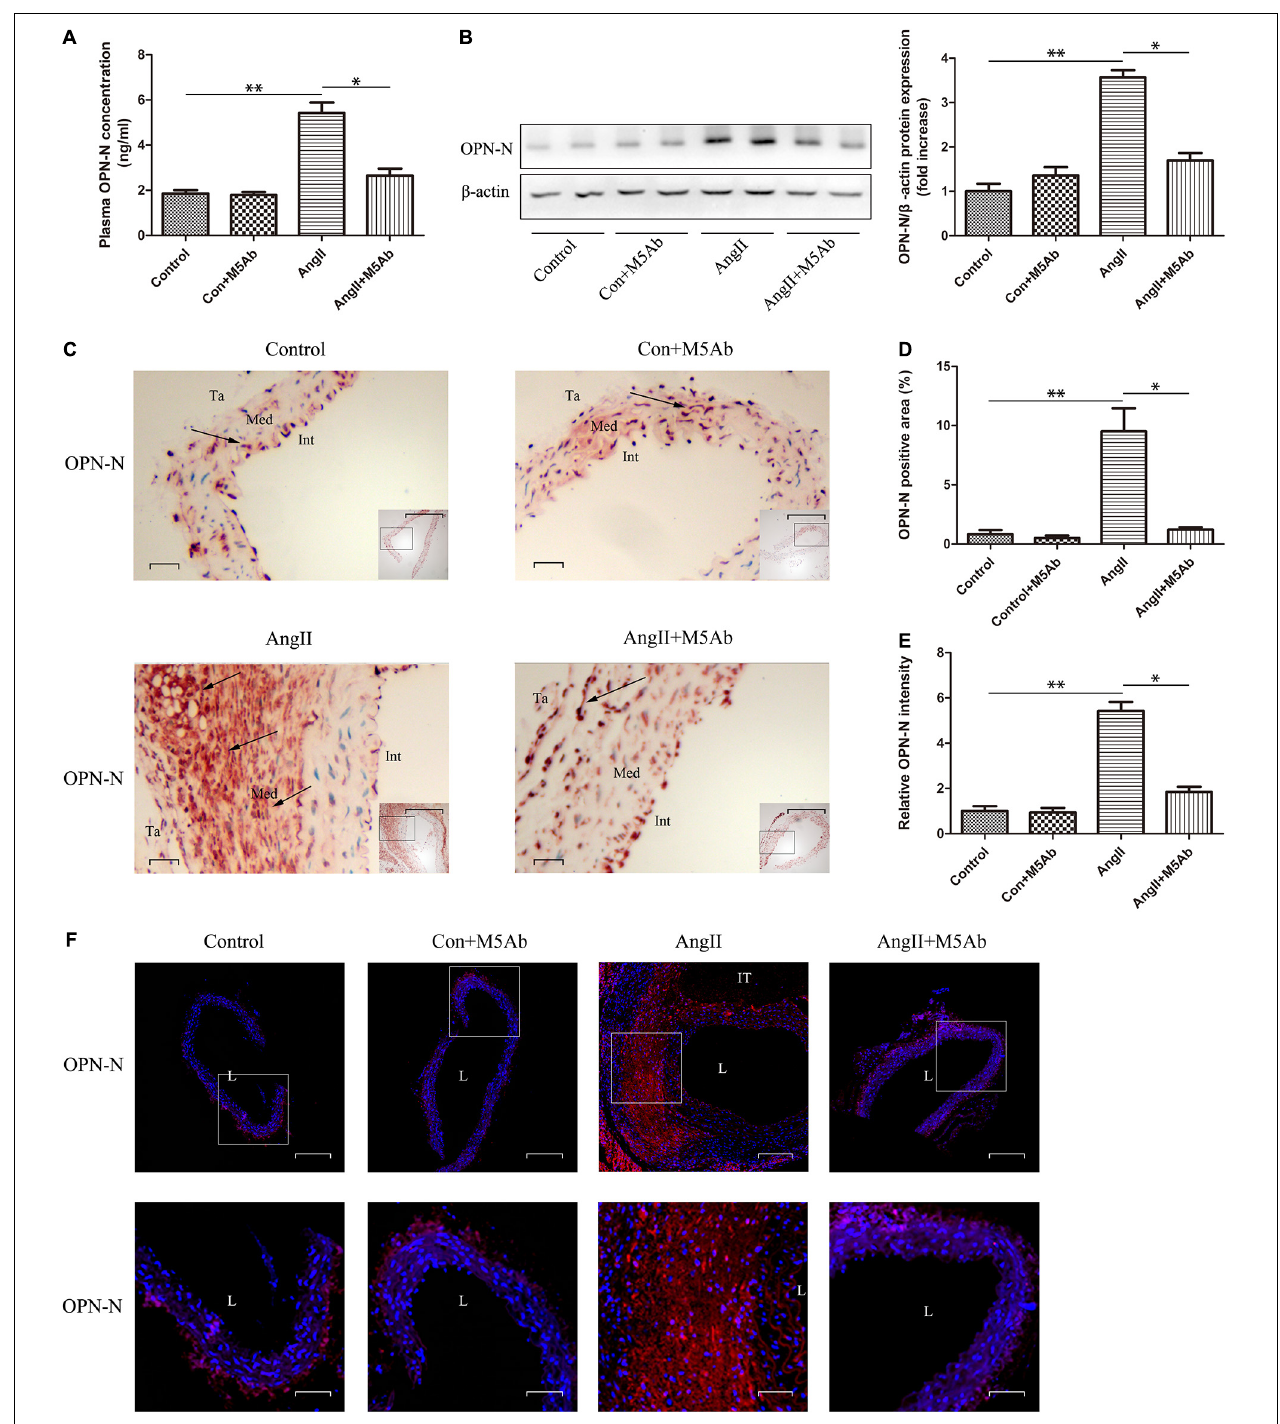
FIGURE 2 | Administration of M5Ab attenuates the expression of OPN-N in ApoE − / − mice with AAA. (A) ELISA analyses of the levels of serum OPN-N in mice under different treatments. (B) Western blotting for OPN-N in mice under different treatments (left), bar graph showing quantification of OPN-N protein expression (right). β -actin was used as an internal control. (C,D) Representative images of aortic immunohistochemistry staining to detect OPN-N expression in mice (black arrows), quantification of OPN-N area. Scar bar 200 µ m, boxed areas; Scar bar 50 µ m, main images. (E,F) OPN-N immunofluorescence staining of aortic tissues in mice and quantification of OPN-N intensity (Scar bar 50 µ m), boxed areas in F are shown at higher magnification below (Scar bar 20 µ m). Data are expressed as means ± SEM; n = 3 per group. ∗ P < 0.05 vs the Ang II + M5Ab group; ∗∗ P < 0.05 vs the control and control + M5Ab groups. Abbreviations: Ang II, angiotensin II; OPN-N, osteopontin N-terminal fragment. DAPI staining of nuclei: blue; OPN-N staining: red. Ta, indicates tunica adventitia; Int, intima; Med, media; L, lumen; and IT, intraluminal thrombus.